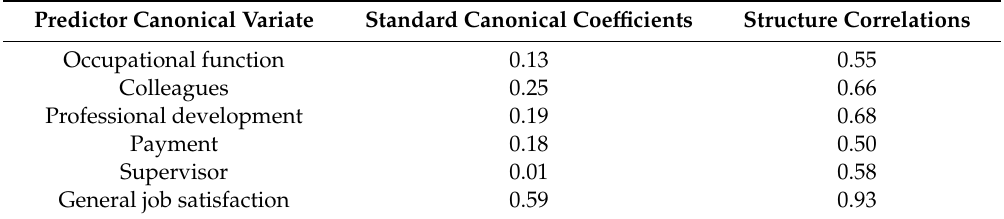
Table 1. Standardizedcanonicalcoefficients andstructure correlations ofthefirstpredictorcanonical variate. Predictor Canonical Variate